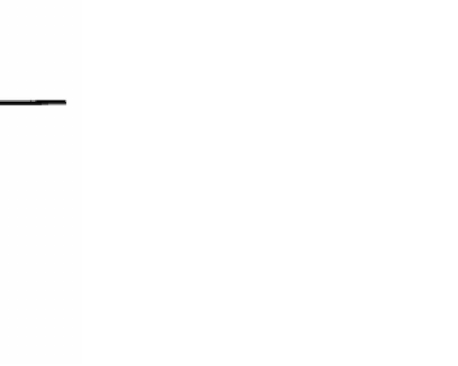
Figure 9. TI–TL band model [57]. Reproduced from Ref. [57], with the permission of AIP